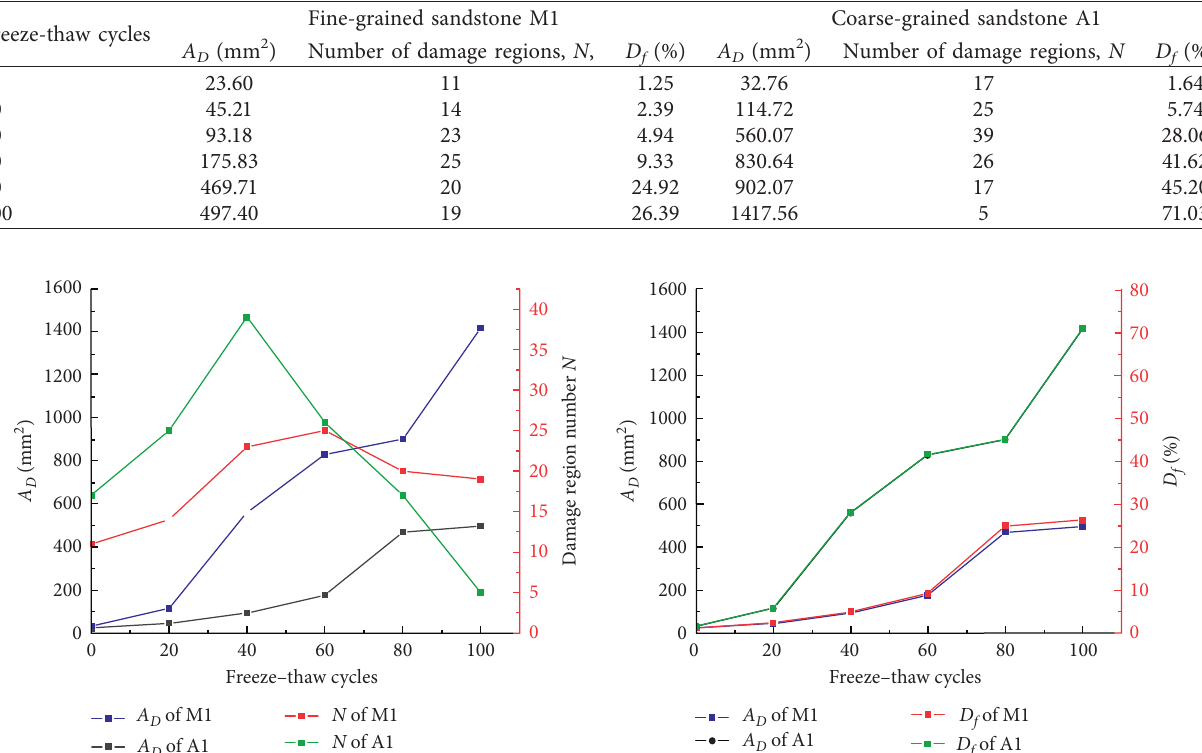
Figure 15: Freeze-thaw damage variable curves with respect to the number of freeze-thaw